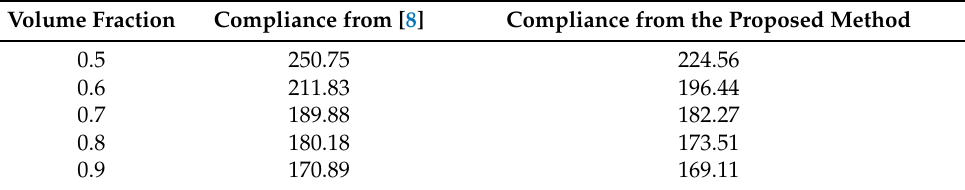
Table 3. Minimized heat transfer compliance for different volume fractions from the literature and the method proposed